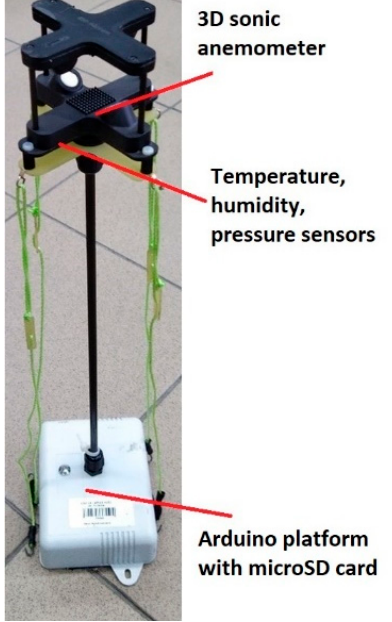
Figure 2. TriSonica TM -based anemometer system.